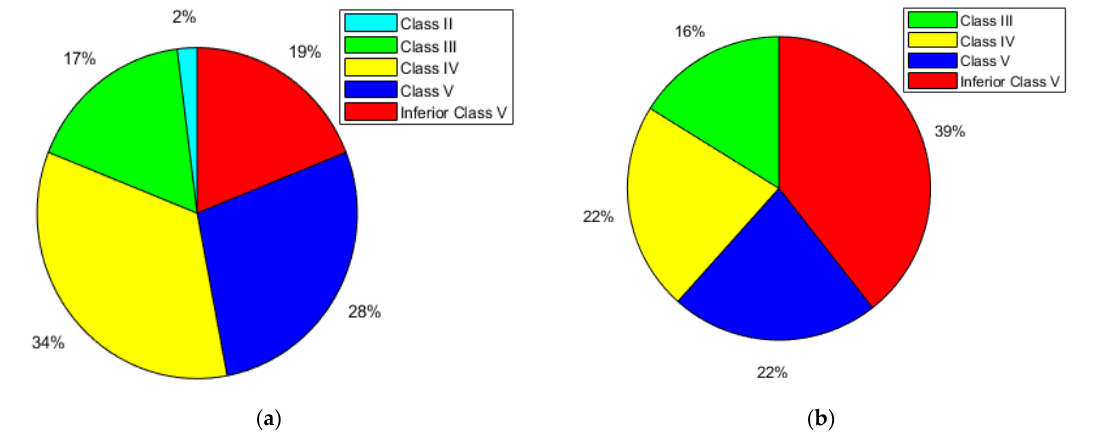
Figure 2. Percentage of lakes in each water quality level: ( a ) Wuhan; ( b ) Huangshi.